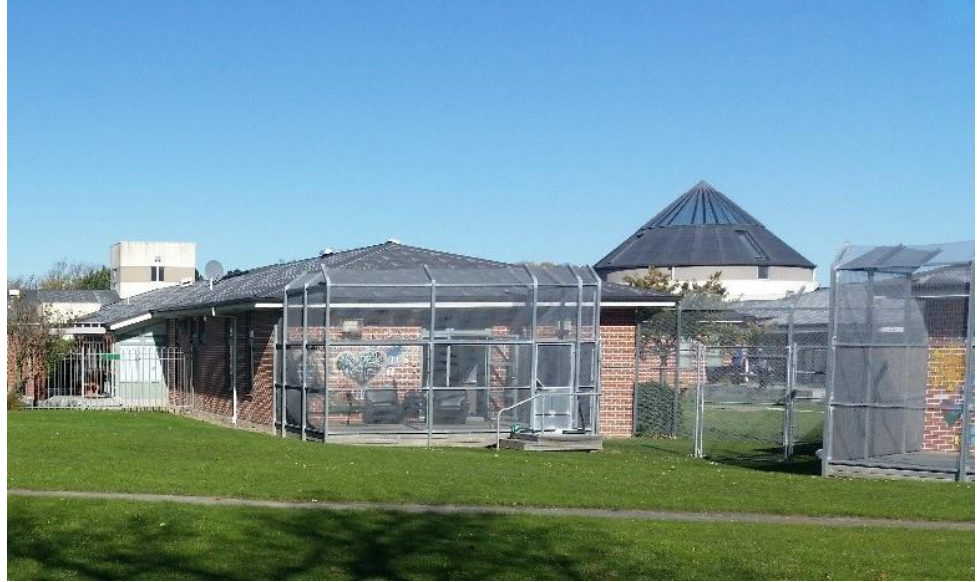
Figure 1. Cage-like screening in an acute mental health ward.